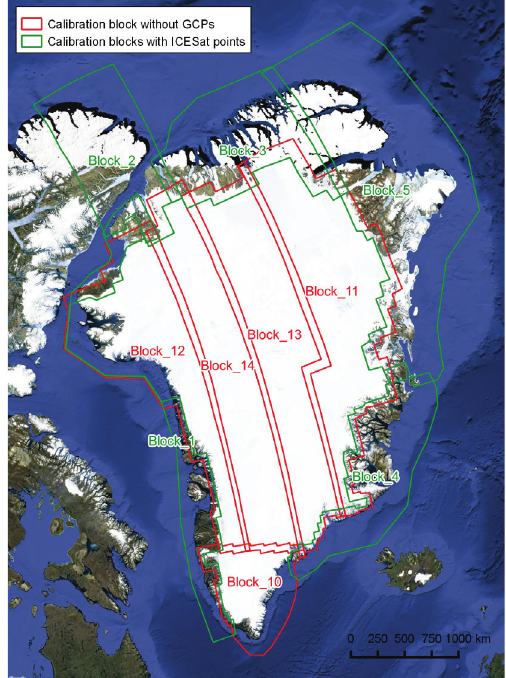
Figure 4. Blocks for adjustment of Greenland: green adjustment to ICESat, red: adjustment by tie-points with no ICESat points